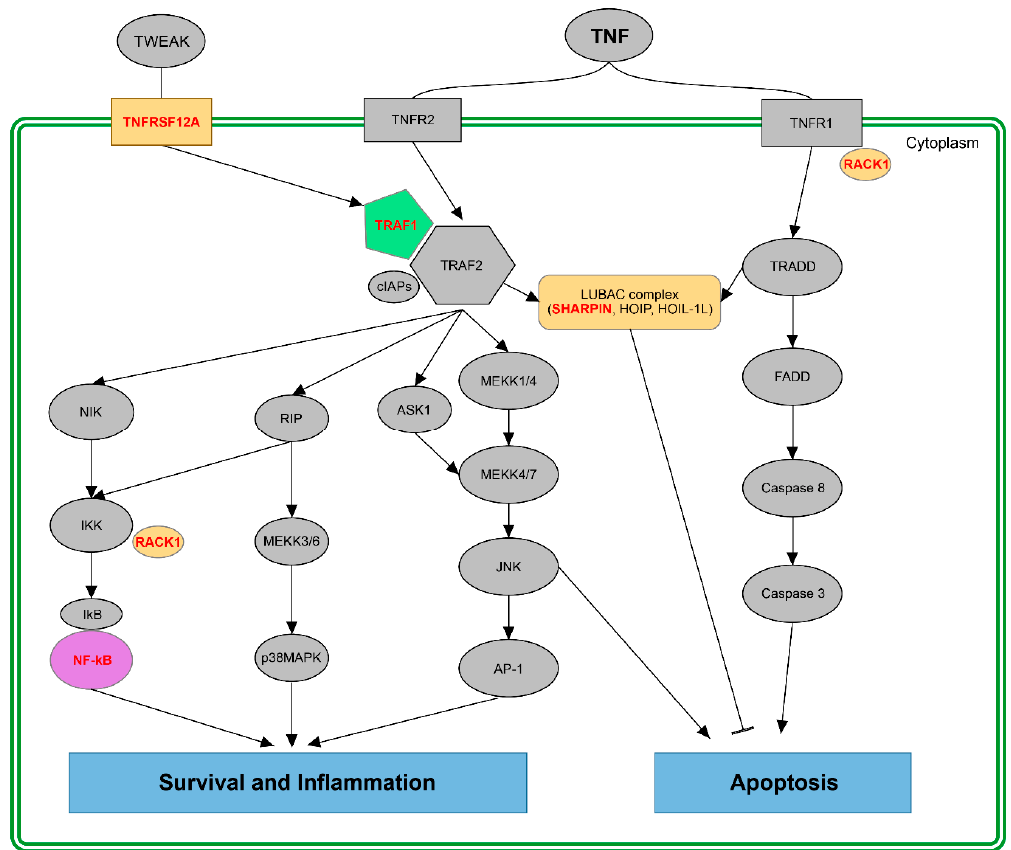
Figure 7. Elements within the TNF pathway possess a time-dependent switching behaviour in isoform expression: TNF can activate different pathways to induce cell survival, inflammation or apoptosis. Cell apoptosis is induced by the activation of Caspase 8 through TRADD and FADD. TRAF1/TRAF2 complex mediates cell survival and inflammation via the JNK-dependent cascade, MEKK cascade and the NF-kB activation by RIP. Elements, which display time-dependent switches in isoform expression are marked in colour with their associated genes marked red. Yellow: elements identified in the HD-MY-Z cell line. Green: elements identified in the LCL-HO cell line. Purple: elements identified in the L-1236 cell line.